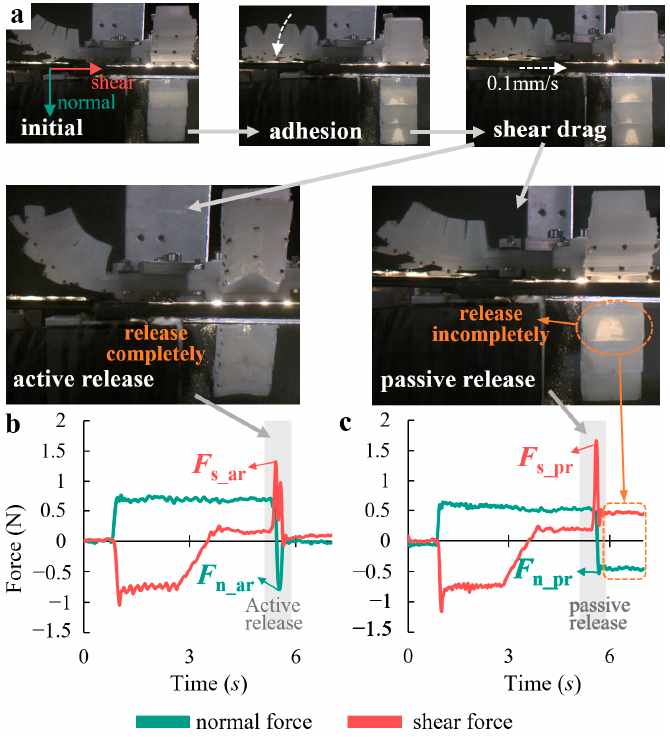
Figure 9. ( a ) Flow of the active/passive release performance test of the bio-toe. Shear and normal forces of the bio-toe during the ( b ) active and ( c ) passive release